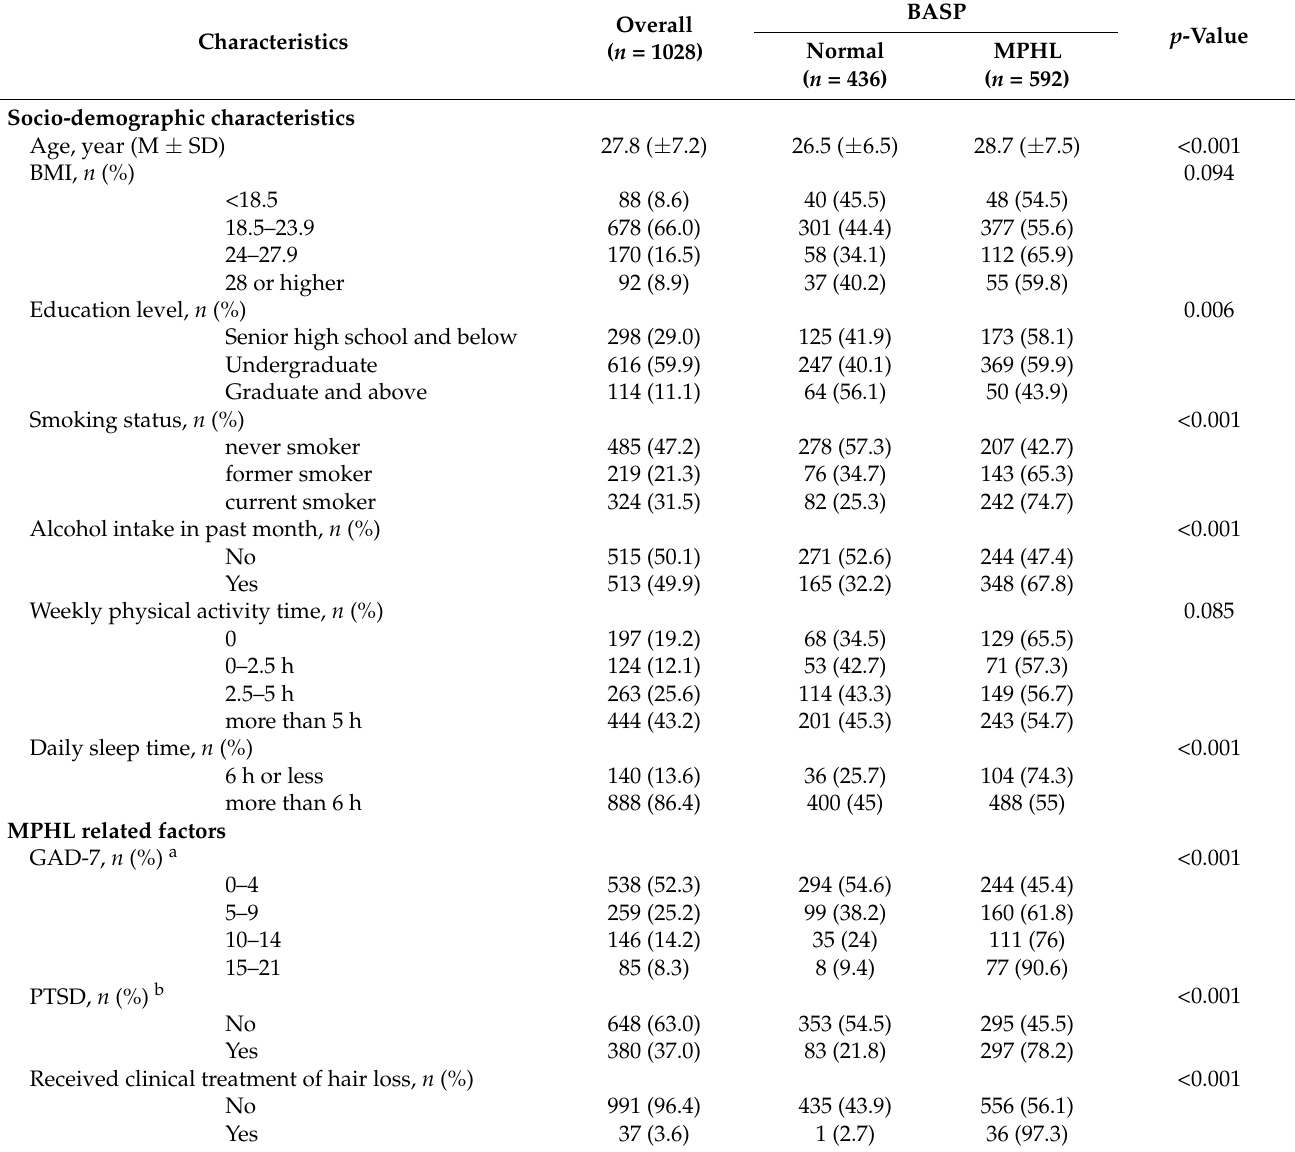
Table 1. Basic characteristics of participants according to Basic and Special (BASP)